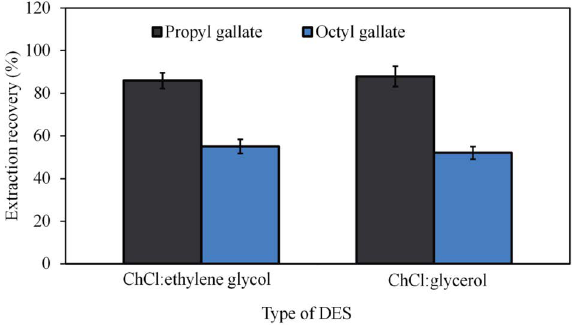
Figure 2. Effect of the type of DES. DES volume, 100 µL; vortex time, 5